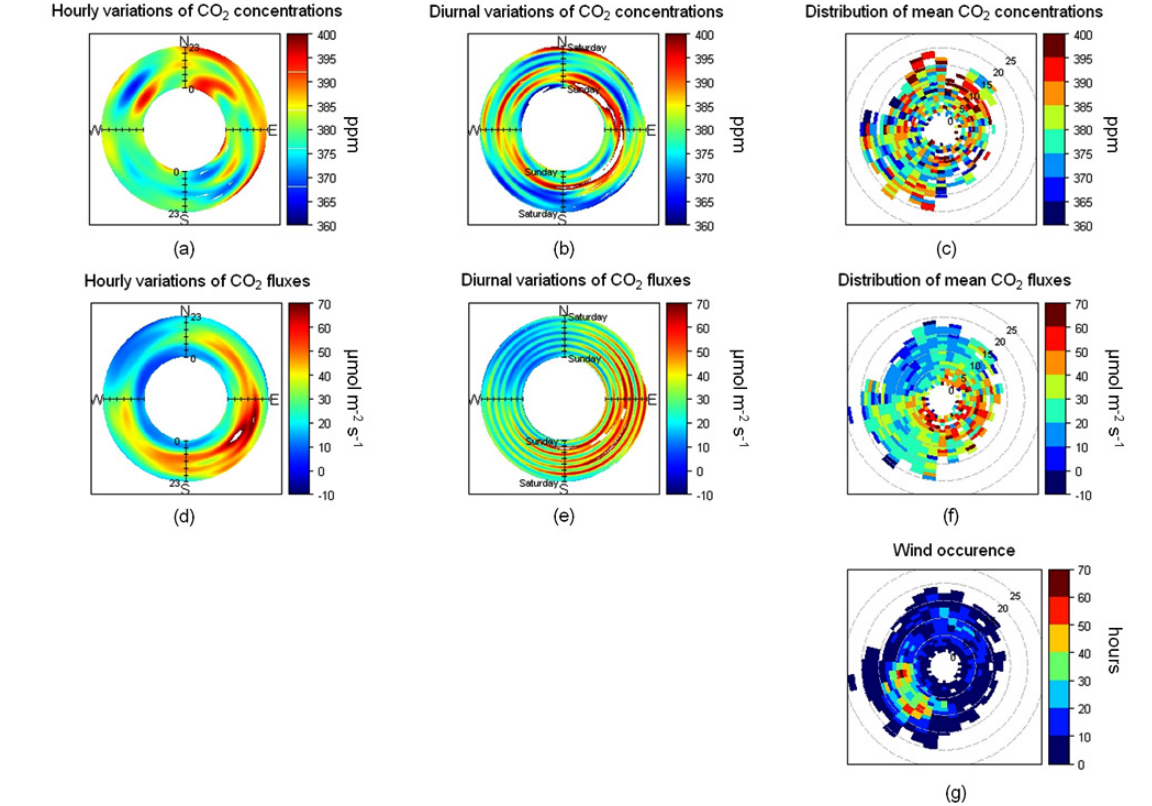
Fig. 7. CO 2 concentrations (inppm) as a function of wind direction average (a) hourly and (b) diurnal variations; variations of CO 2 fluxes (in µmolm − 2 s − 1 ) as a function of wind direction average (d) hourly and (e) diurnal; (c) , (f) distribution of CO 2 concentrations (ppm) and CO 2 fluxes (µmolm − 2 s − 1 ) as a function of wind direction and wind speed; (g) wind occurrence (in hours) as a function of wind speed and direction. Plots were generated using the openair (Carslaw and Ropkins, 2010) package for R (R Development Core Team,